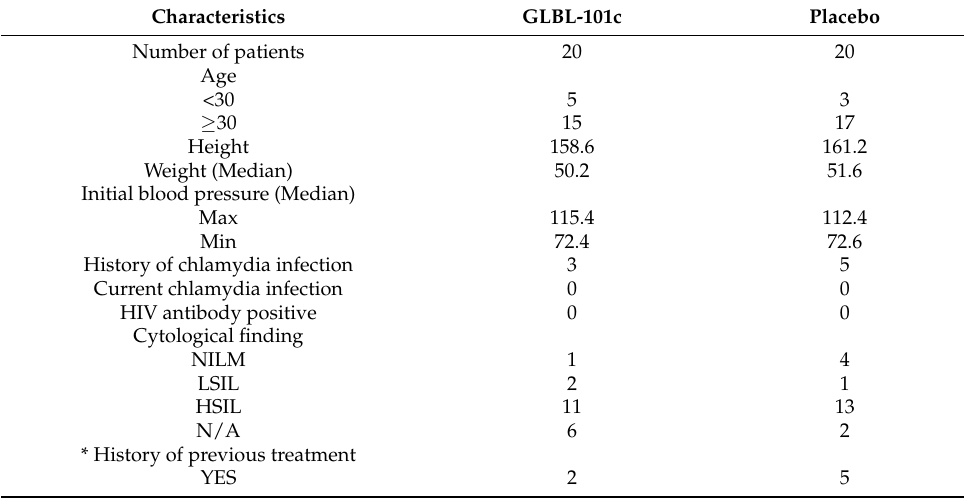
Table 1. Characteristics of participants in this